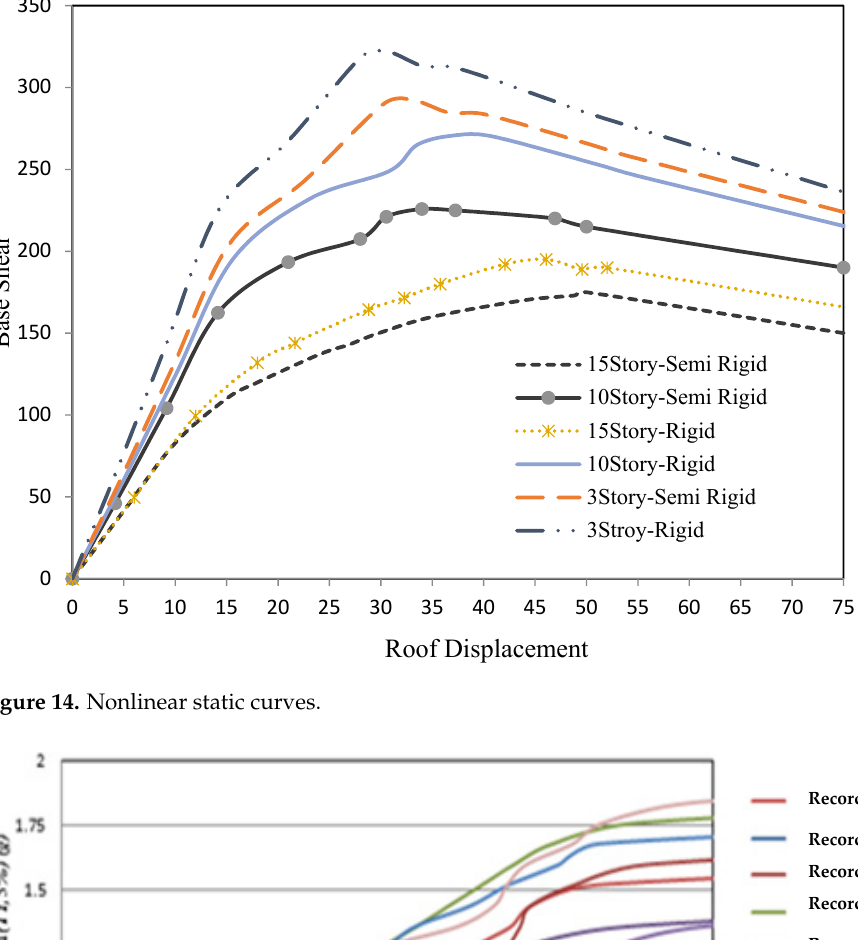
Figure 14. Nonlinear static curves.